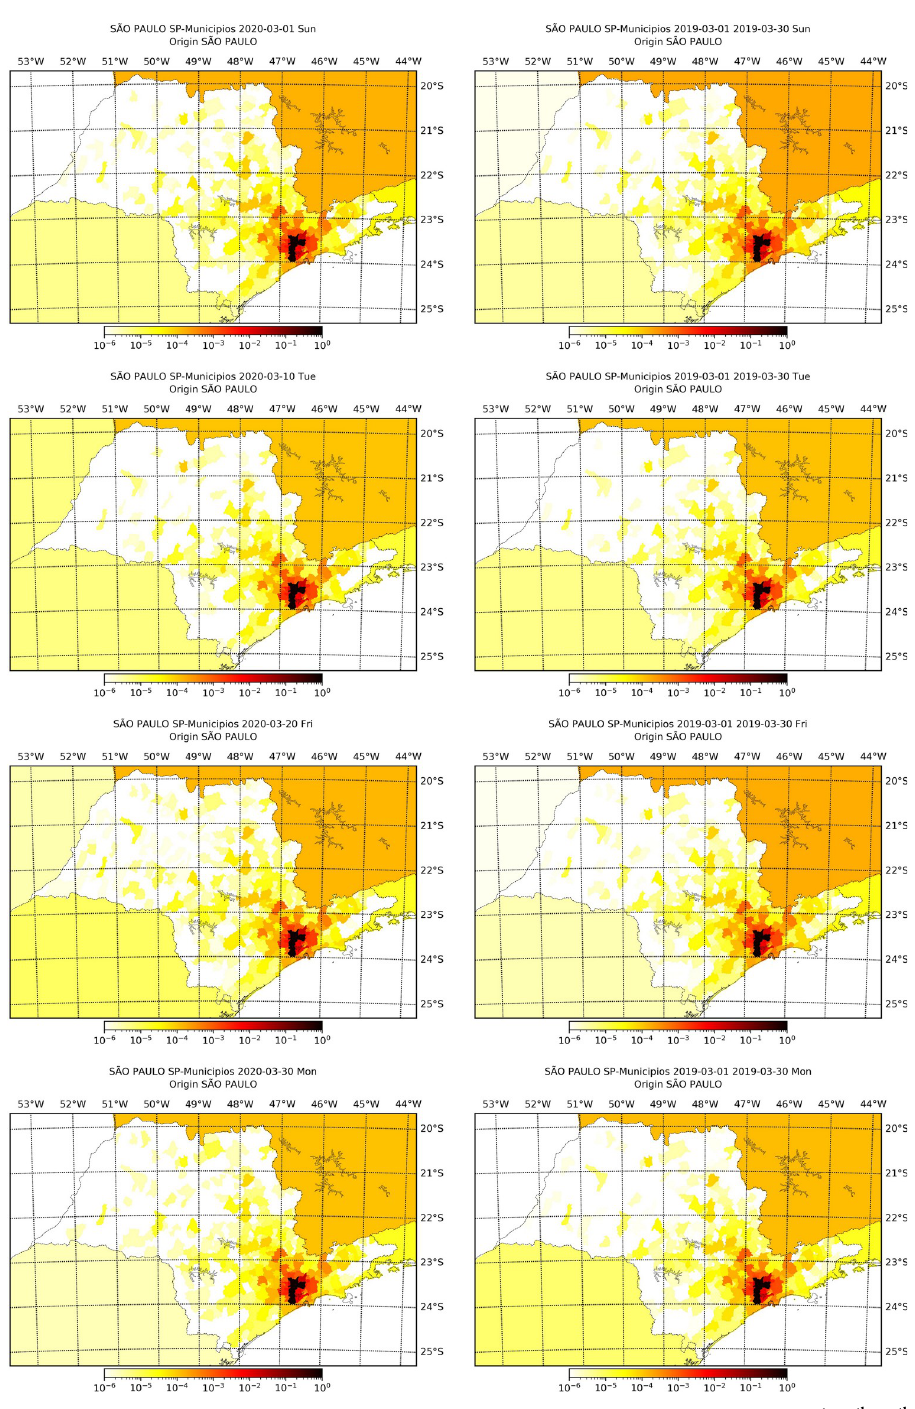
Fig 4. Proportion of movement from S ã o Paulo capital city to each city within the state at March 1 st , 10 th , 20 th and 30 th of 2020 alongside with the mean proportion of movement of the respective weekday in March 2019. in 2019 is close to the rank in 2020, evidencing again that, even though movement has decreased, the pattern of movement has not changed. These top cities are mainly in the metropolitan region of the capitals, an evidence that these may be future foci of infection.